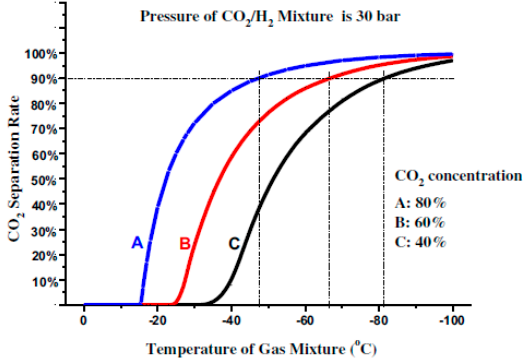
Figure 2. Variation in CO 2 concentration and separation ratio of CO 2 /H 2 mixture with temperature [8].